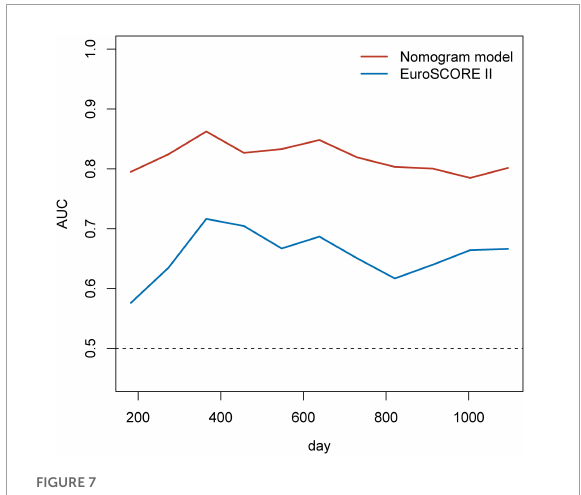
FIGURE7 Time-dependent AUCs over time for EuroSCORE II and the nomogram for predicting the overall survival. EuroSCORE II, European System for Cardiac Operative Risk Evaluation II; AUC, area under the receiver operator characteristic